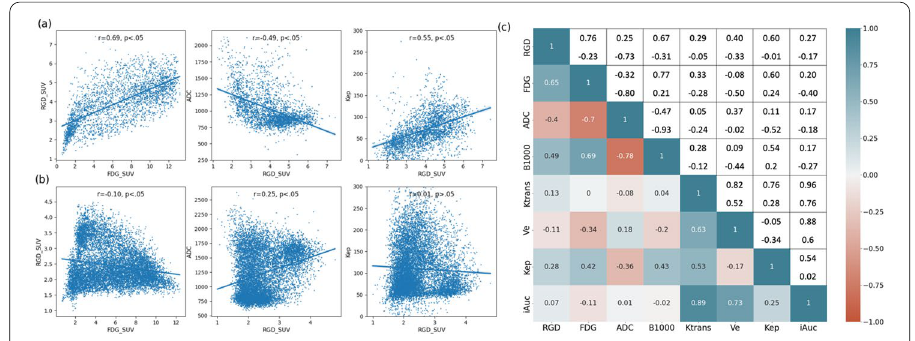
Fig. 2 Representative scatter plots for patient 3 ( a ) and patient 5 ( b ), showing voxel-wise distribution of selected pairs of parameters. On the right side ( c ), the correlation matrix of median Spearman correlation coefficient between all investigated parameters (lower-left triangle) and its range across all patients (upper-right